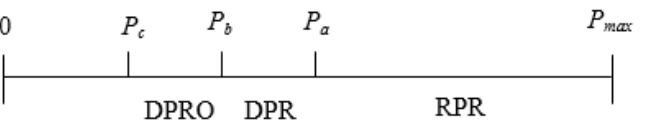
Figure 1. Schematic diagram of the unit peak regulation process. P a is the minimum technical capacity of the unit at the regular peak regulation (RPR) stage, P b is the minimum rated capacity at the deep peak regulation (DPR) stage, and P c is the minimum stable output at the deep peak regulation with oil (DPRO) stage.